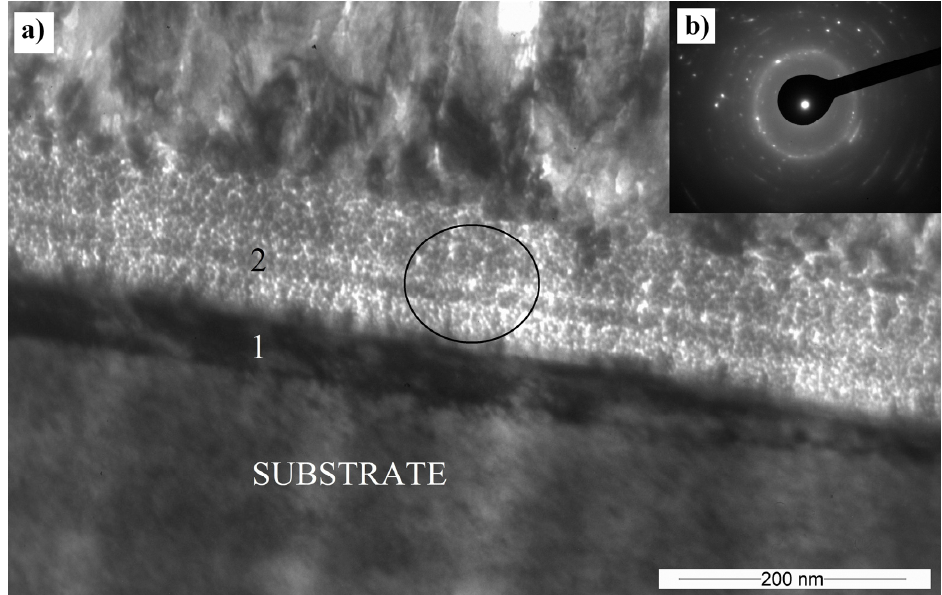
Figure 8. ( a ) TEM cross-sectional BF image of the Cr 2 AlC coating interface, deposited at 90 V (1; substrate part of interface, 2; coating part of interface); ( b ) Selective area electron diffraction (SAED) obtained in the place marked by the circle.